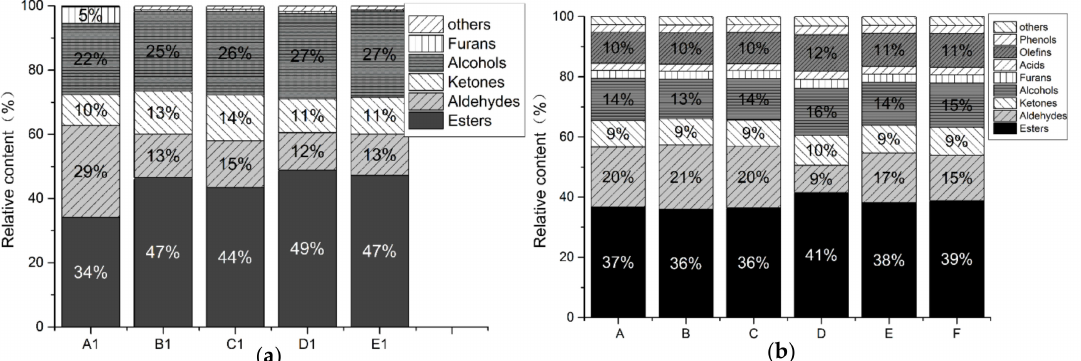
Figure 5. The relative content of VFC during the fermentation of TN ( a ) and CTN ( b ). Notes: TN refers to the enhanced fermentation tomato sour soup sample (A1–E1); CTN refers to the traditional tomato sour soup sample (A–F). Each type of flavor is represented by a unique color. Each column represents a different studied